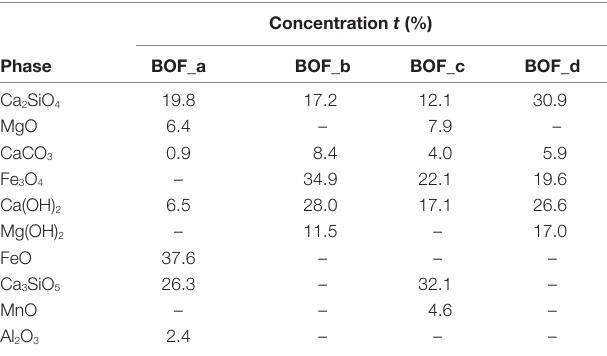
TaBle 2 | Mineralogical composition assumed for the BOF slags on the basis of the results of XrD and other chemical analysis.